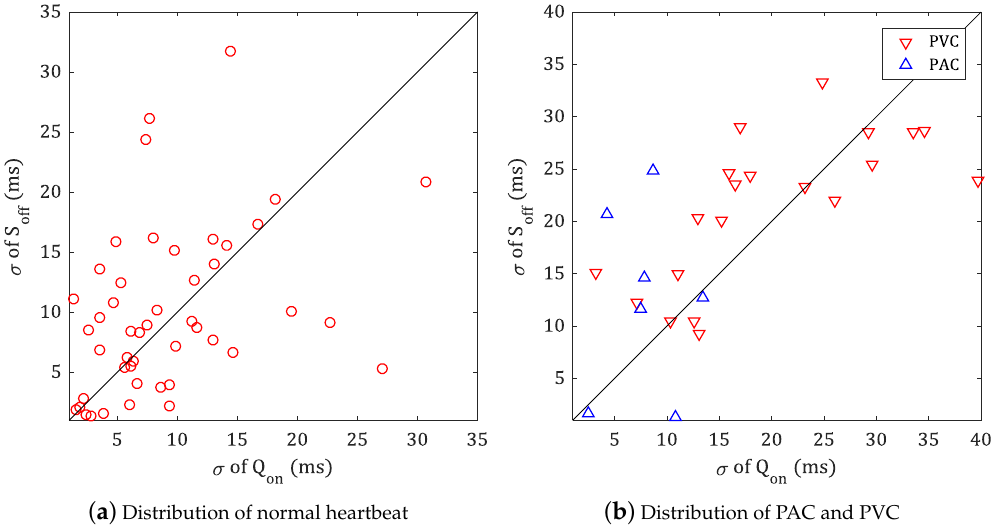
Figure 12. Distribution of standard deviation for MIT-BIH